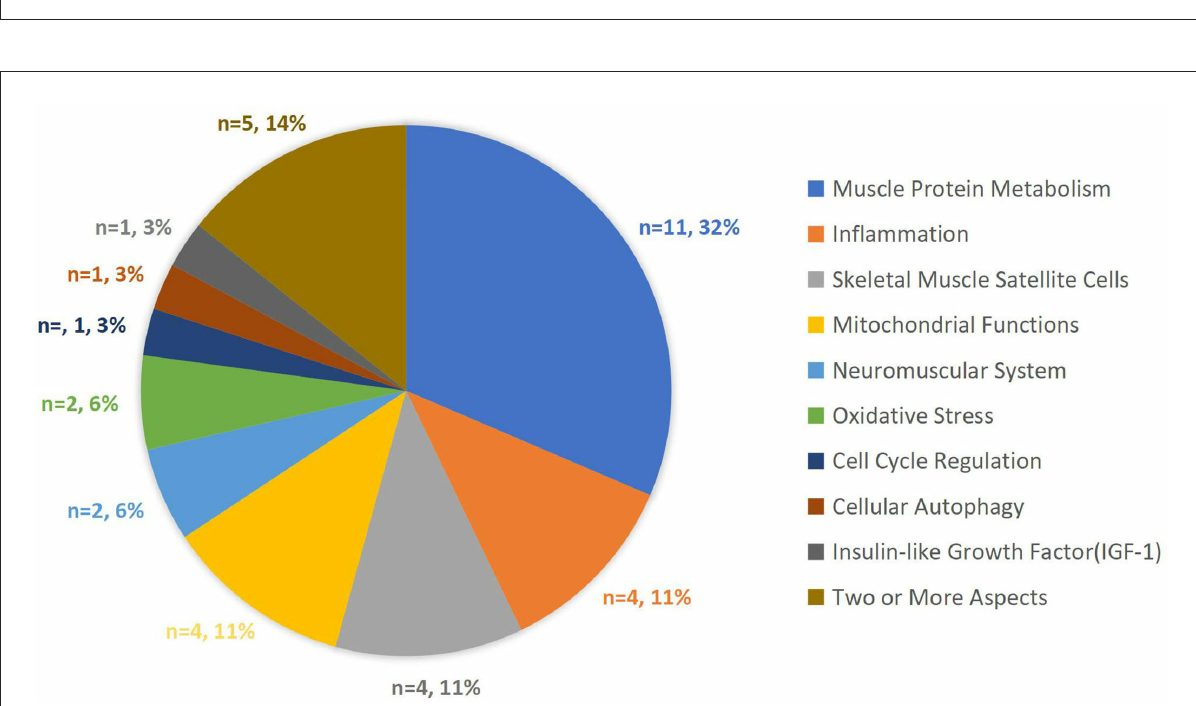
FIGURE4 Different exercise strategies studied in the top 100 articles (size of the rectangle area represents frequency).